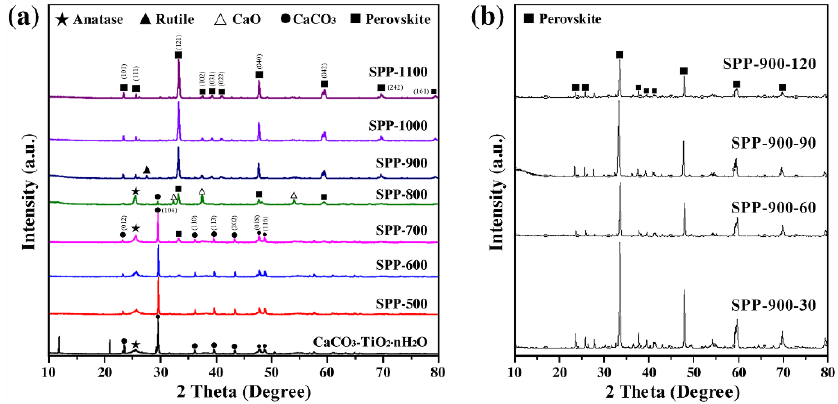
Figure 1. XRD patterns of ( a ) CaCO 3 ‐ TiO 2 nH 2 O calcined at different temperatures and ( b ) for different times (SPP ‐ 900).